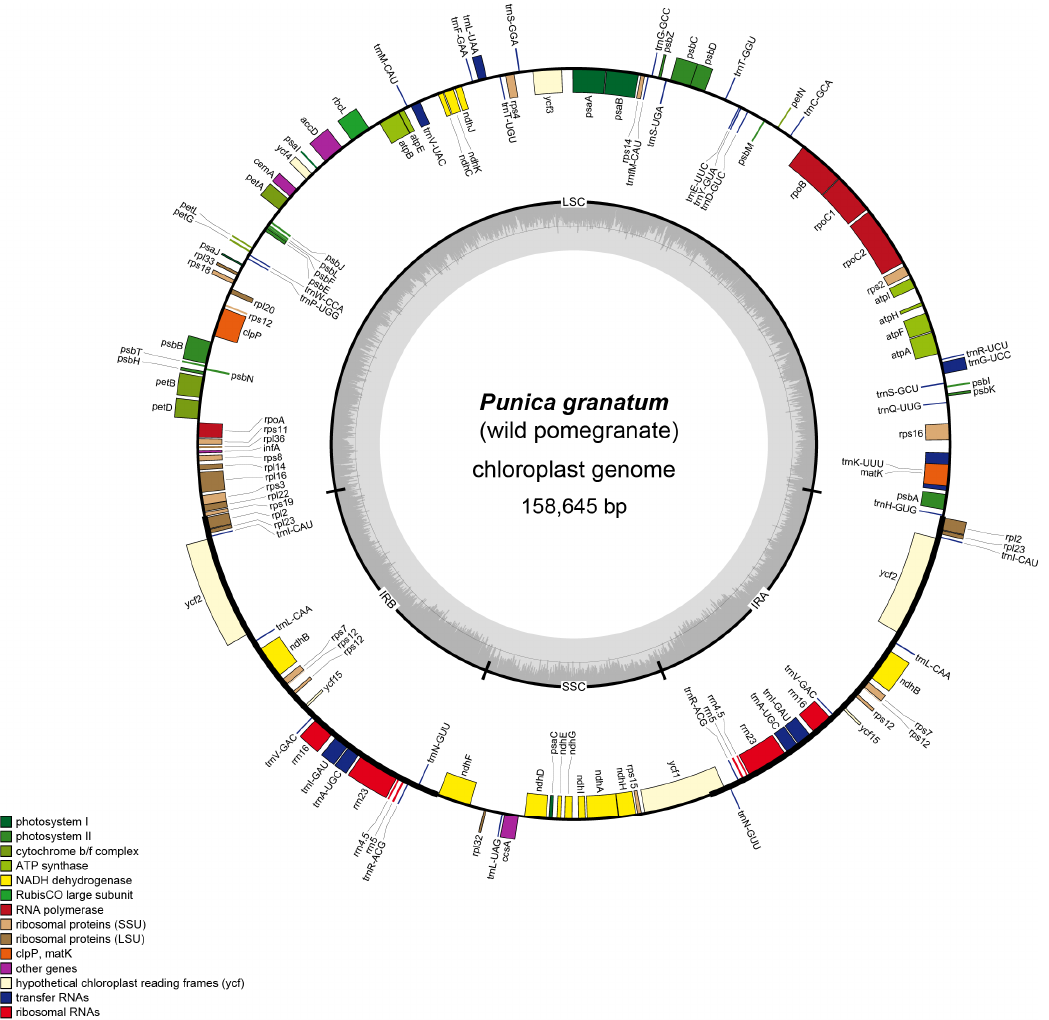
Figure 1. Diagrammatic map of the wild pomegranate chloroplast genome. The dense line in the exterior region represents inverted repeats (IR) namely (IRA via IRB). The genes that are shown in the anterior region are transcribed clockwise, and other genes that are outside are transcribed counterclockwise. Furthermore, the genes that belong to various functional groups are color-coded. And, the dark grey in the anterior region represents the GC content. Table 1. Summary of the wild pomegranate chloroplast genomes with other nine related species.